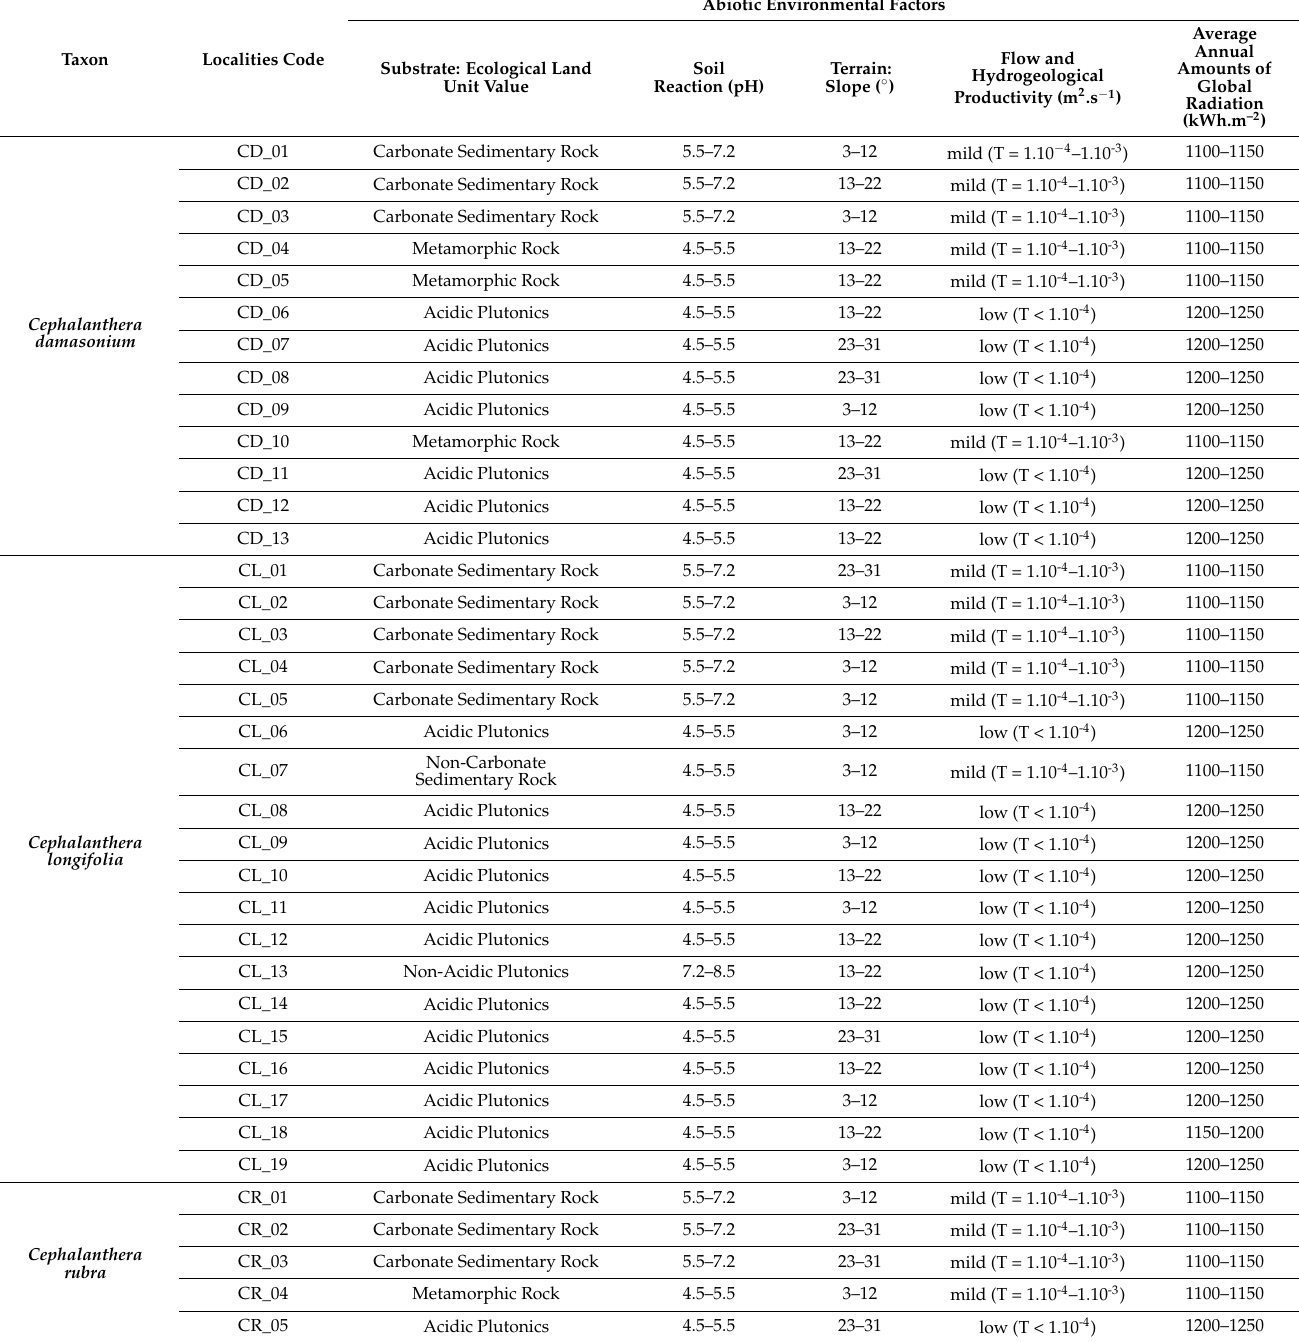
Table 1. Statistical processing of ecological environment factors. *We do not analyze Neottia nidusavis in terms of the high number of sites and low ecological